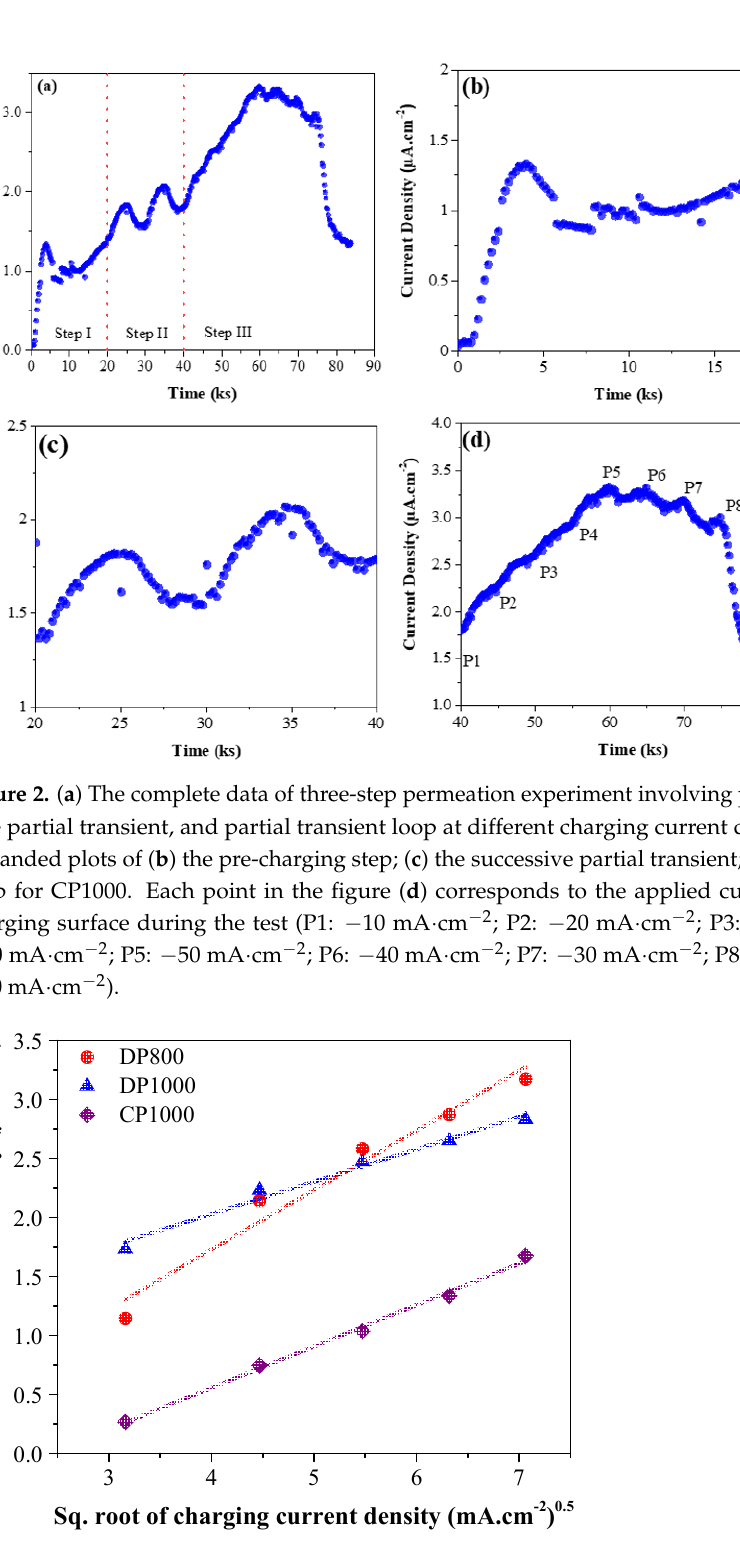
Figure 3. The variation of steady-state permeation current density with the square root of charging current density. A linear relationship is assumed, suggesting a permeation current controlled by the impressed cathodic current density.